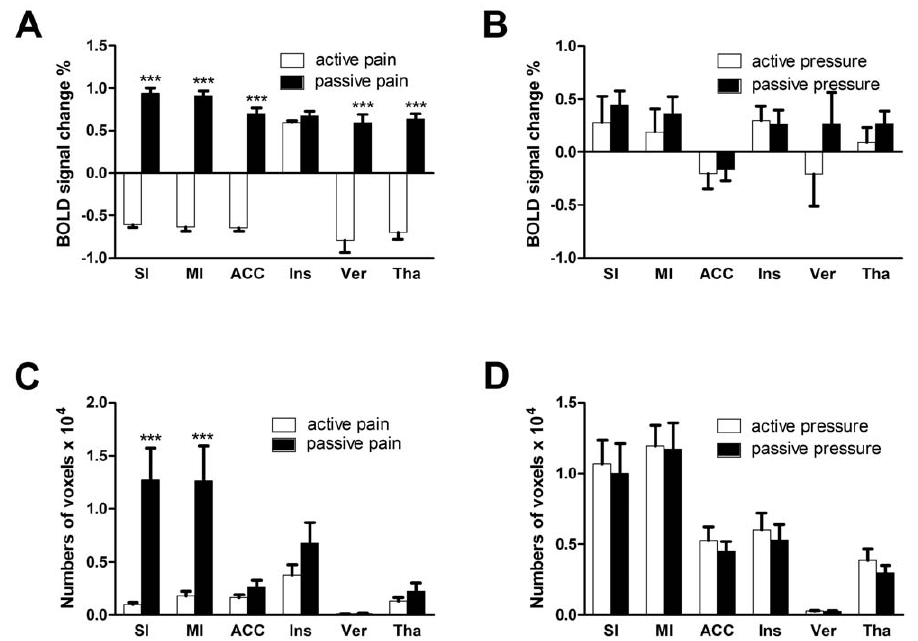
Figure 4. Statistics on functional brain activation. Mean intensities of BOLD signals and activated voxel numbers in the ROIs in active and passive pain conditions were compared. (A) In all ROIs except the insula, BOLD signal intensities were higher in passive pain than that in active pain condition. (B) No such difference could be found between active and passive pressure. (C) Passive pain activated significantly more voxels in the primary somatosensory and motor cortices. (D) No significant difference was observed between the two types of pressure.